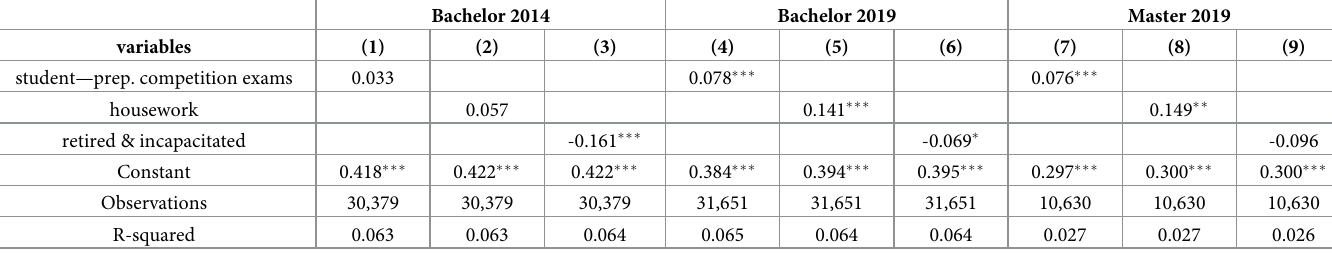
Table 6. Association between different situations of inactivity and dissatisfaction with university